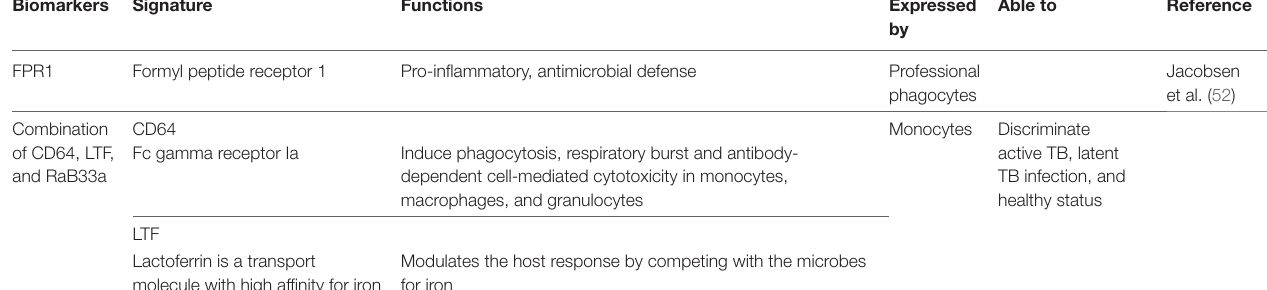
TABLe 2 | List of identified biomarkers based on monocytes for tuberculosis (TB). Biomarkers